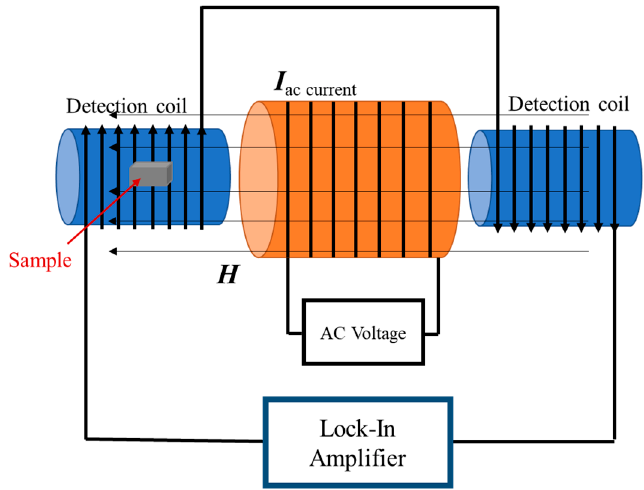
Figure 2. B–H looper setup